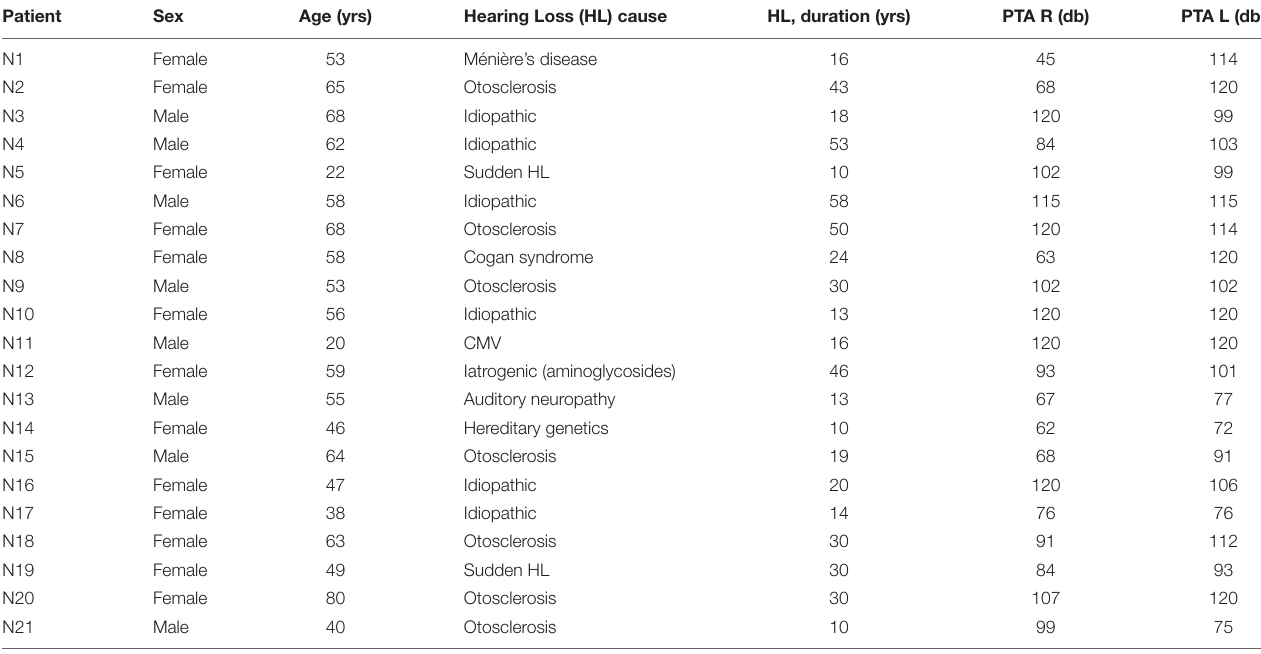
TABLE 1 | Patients’ demographic characteristics, causes, and duration of hearing loss (HL) and preoperative audiometric data. Patient